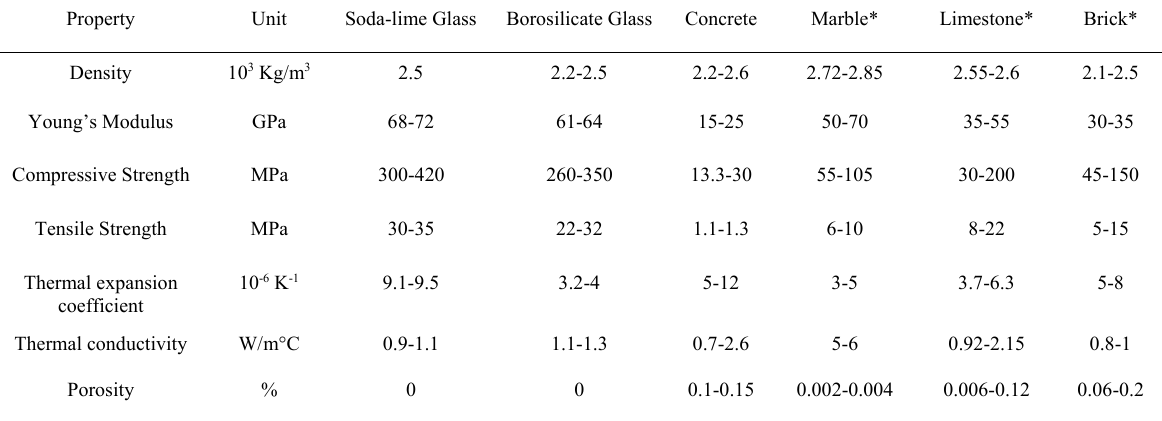
Table 1: Properties of materials used in consolidation treatments derived from the Glass Construction Manual (Schittich et al. 2007) and CES Edupack 2017 Software (Granta 2017).